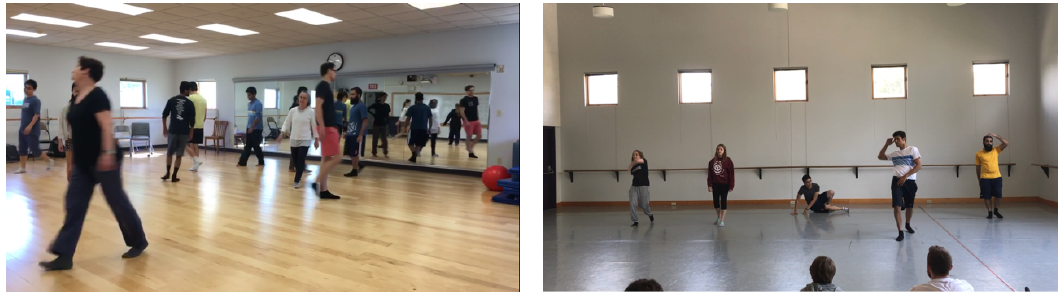
Figure 4. The same prompt can create distinct resultant compositions; here, two very different takes on an initial seed of